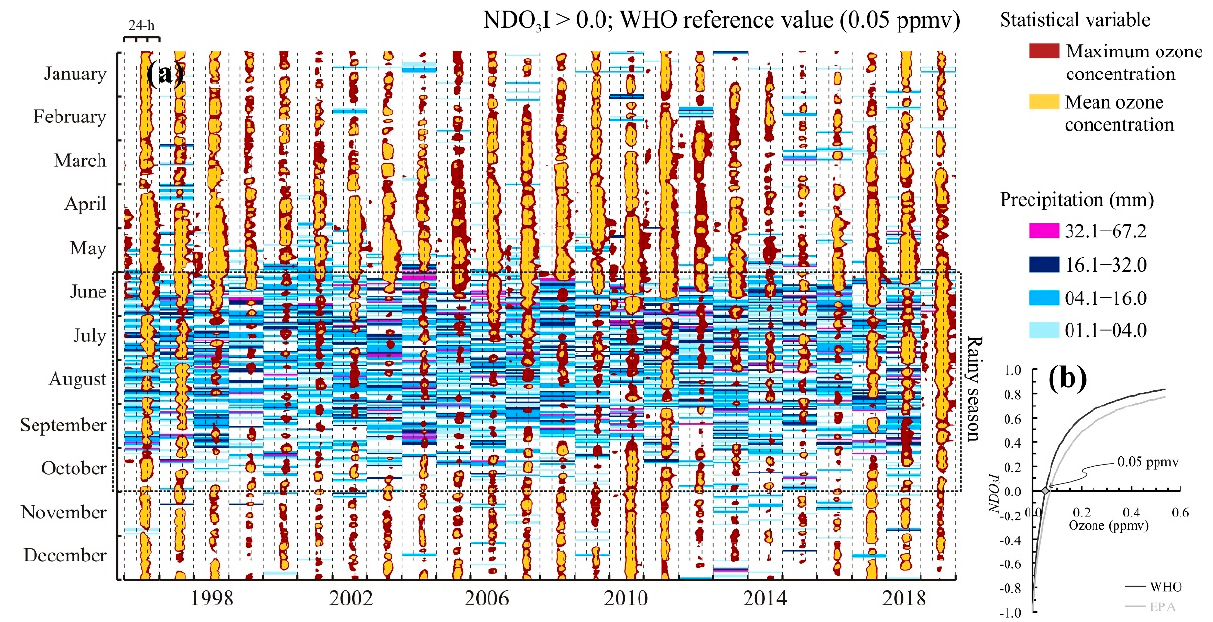
Figure 7. (a) Ozone measurements above the WHO’s guidelines are expressed in terms of the ozone index (NDO 3 I) over twenty-four years in the Guadalajara Metropolitan Area. (b) Graphical representation of the NDO 3 I referred to the WHO’s limit.